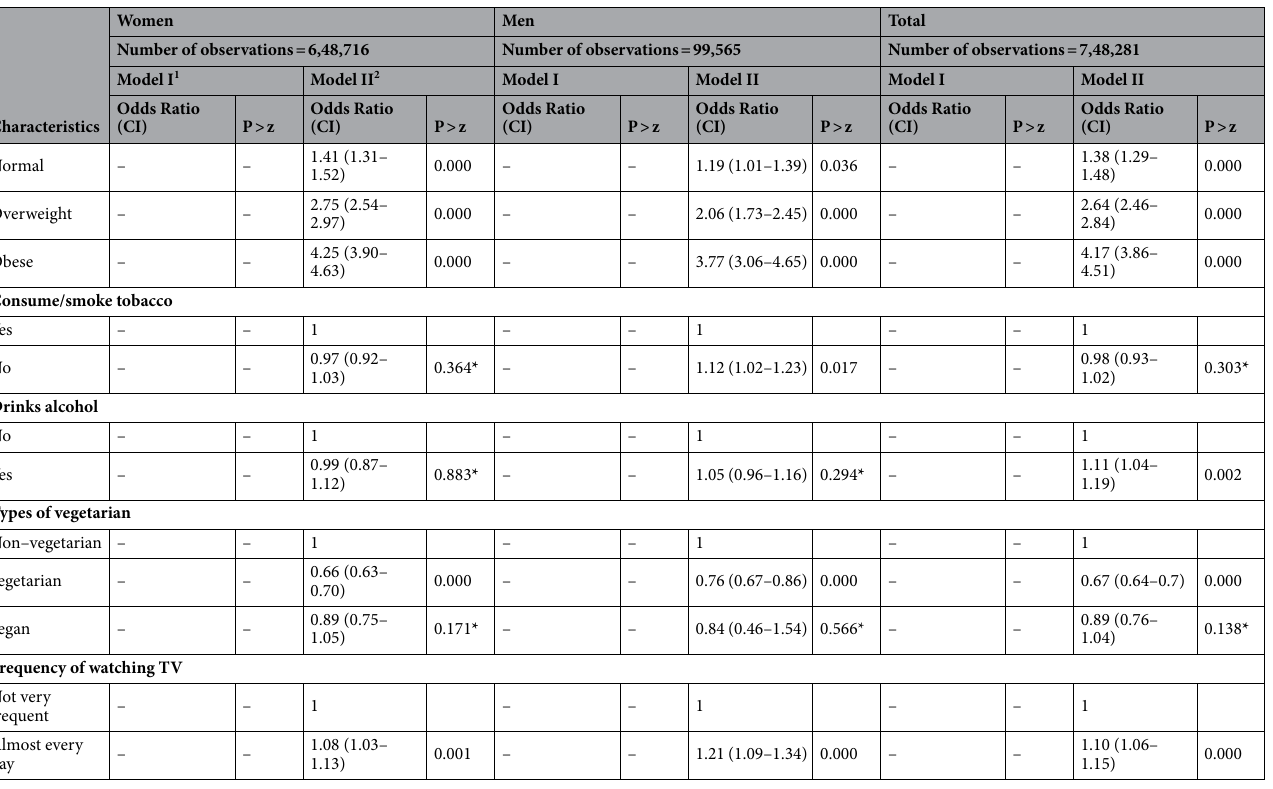
Table 5. Multivariate Logistic regression table showing the association between diabetes and different socioeconomic and demographic variables and risk factors. Model I is adjusted to socioeconomic and demographic variables. Model II is adjusted to all the risk factors along with socioeconomic and demographic variables. *Not significant at 95% confidence interval. Note: Values in parenthesis are confidence